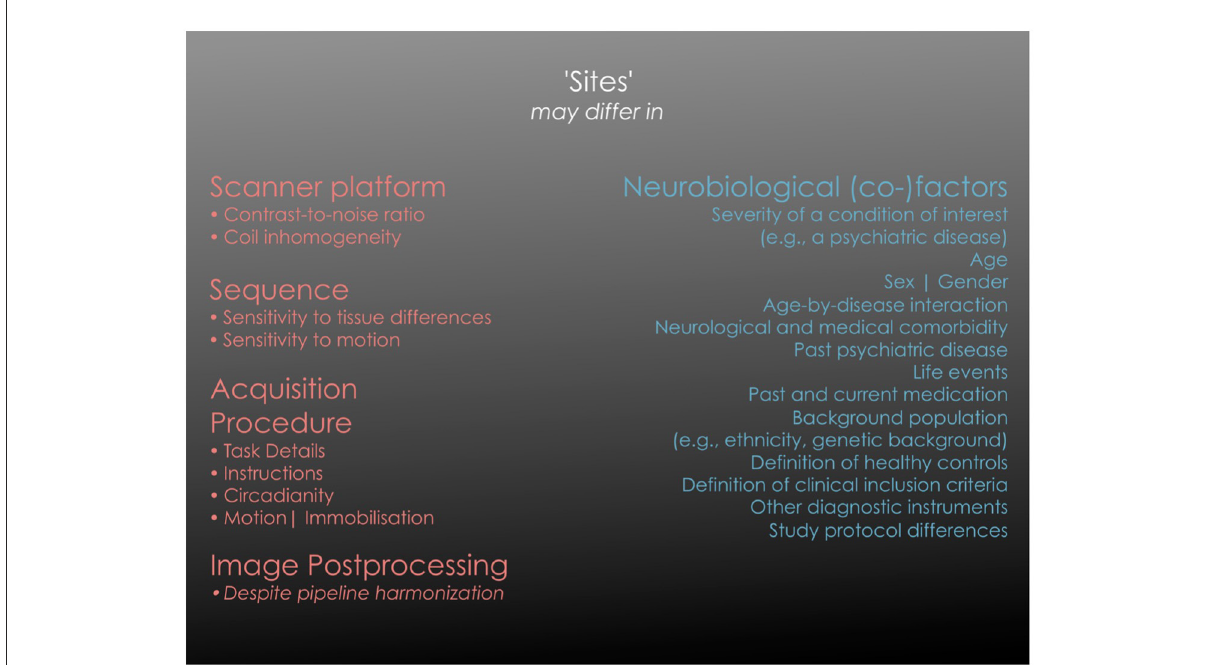
FIGURE1 Overview of different sources of site effects. The left column lists categories of technical factors that are bound to a specific acquisition site and that may significantly influence the primary image properties. “Scanner effect” is often used as an abbreviation for “image acquisition platform” in a wider sense while it incorporates numerous technical components. In active tasks where researchers or technicians intervene as part of the study protocol (e.g., provide instructions to participants), additional site specific effects of a systemic nature may appear. The right column lists factors that may be variables of interest (such as a disease status) or variables of no interest, depending on the study question. Each of them may be site-specific and thus co-vary with the specific site in a multi-site analysis, imposing the challenge of disentangling the two sources of “site effects”. It should be noted that “variables of no interest” may still be essential for an adequate statistical model of the biological effects (e.g.,